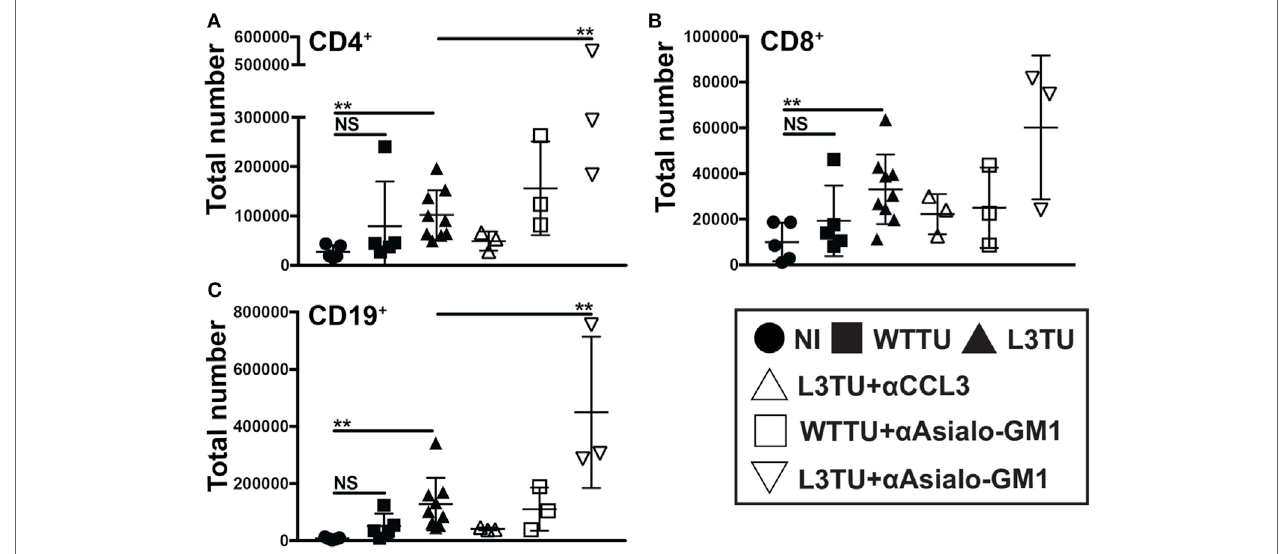
FigUre 4 | The enhanced accumulation of leukocyte subsets in the L3TU tumor-draining lymph node (TDLN) is negated by blocking CCL3, but enhanced by natural killer (NK) depletion. (a–c) Absolute numbers of immune cell subsets in the TDLN 5 days post-tumor injection of mice with and without the anti - CCL3 blocking Ab or NK cell (anti-Asialo-GM1) depletion Ab. N = 3 mice per cohort. NI (circles), WTTU (squares), and L3TU (triangles) cohorts were conducted concurrently along with the CCL3-blocking and NK depletion cohorts. IgG1a antibody was administered to WTTU, and L3TU cohorts as controls. Not significant (ns), p > 0.05; * p = 0.01–0.05; ** p = 0.001–0.01; *** p = 0.0001–0.001; **** p <